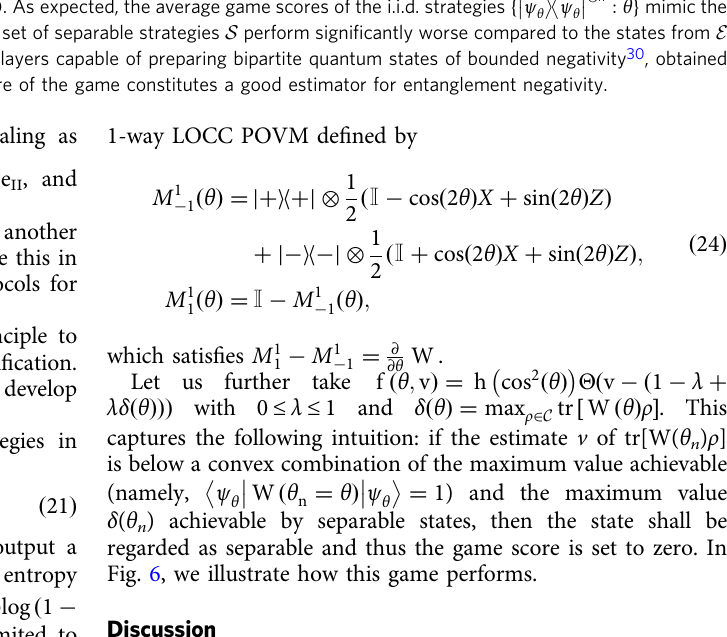
(cid:12) (cid:13) ; M 0 in 1 (cid:7) 1 (cid:4) (cid:5) (cid:4) for n = 41 (cid:4) (cid:11) (cid:4) (cid:5) (cid:4) (cid:3) n : θ g mimic the (cid:4) ψ θ